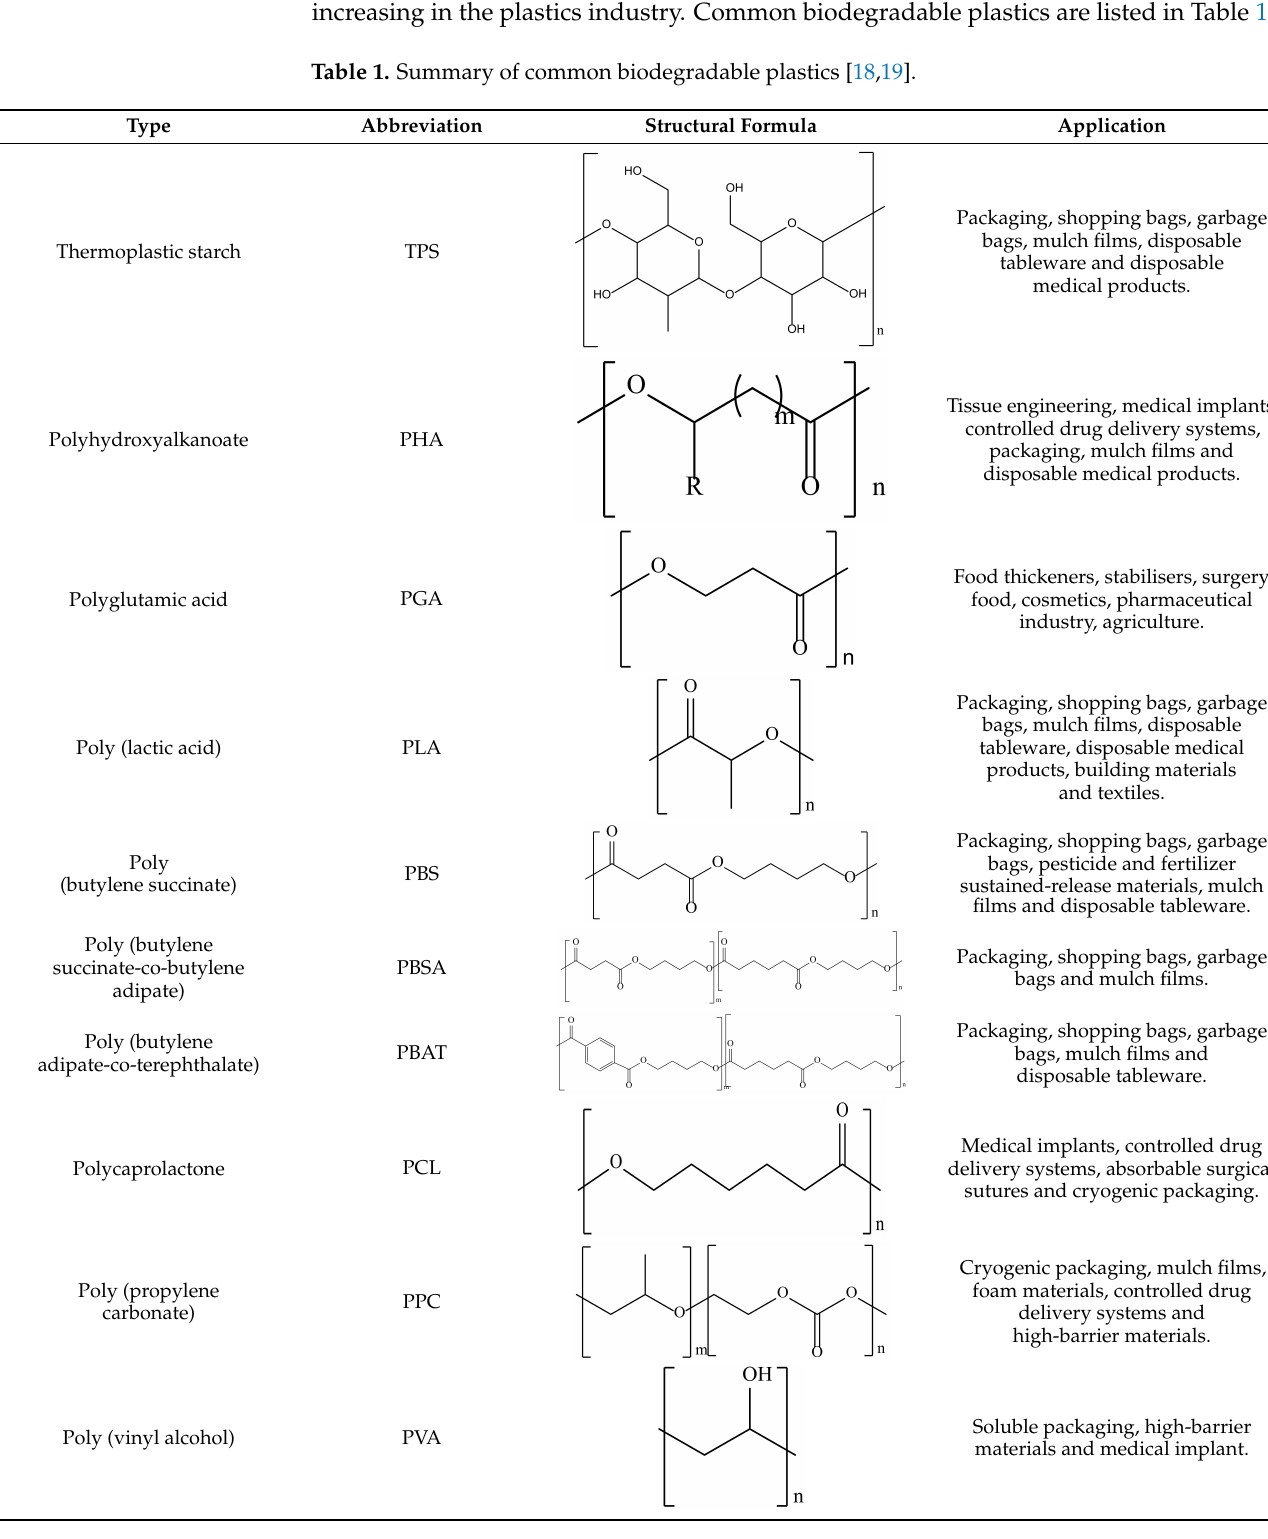
Table 1. Summary of common biodegradable plastics [18,19].